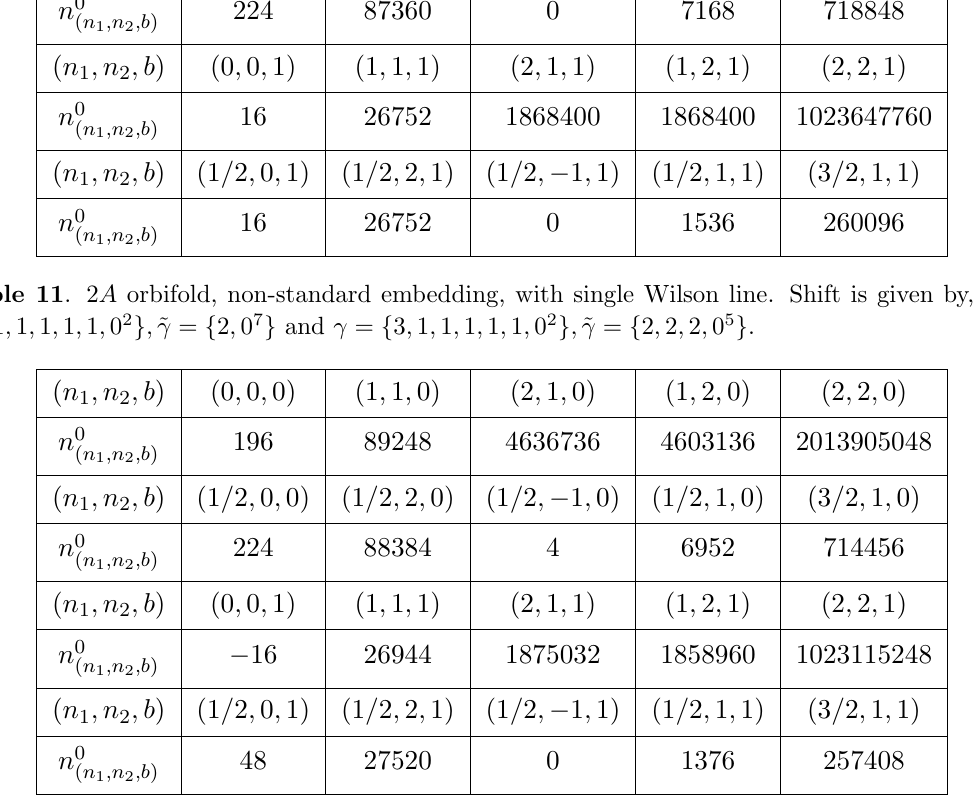
Table 12 . 2 A orbifold, non-standard embedding, with single Wilson line. Shift is given by, (cid:13) =